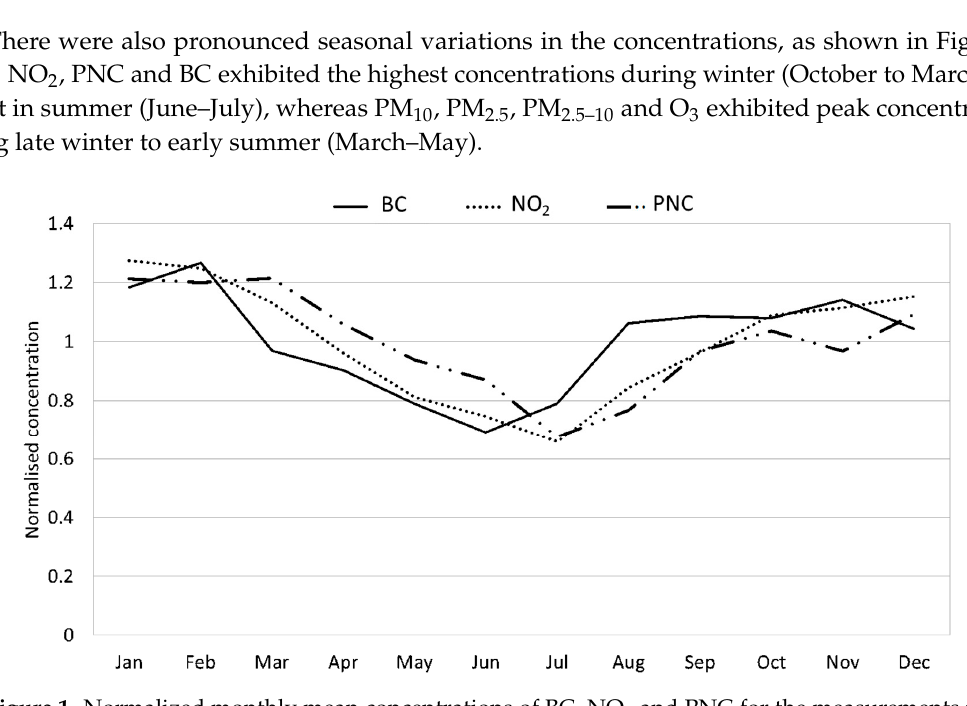
Figure 1. Normalized monthly mean concentrations of BC, NO 2 and PNC for the measurements in central Stockholm during 2000–2016.